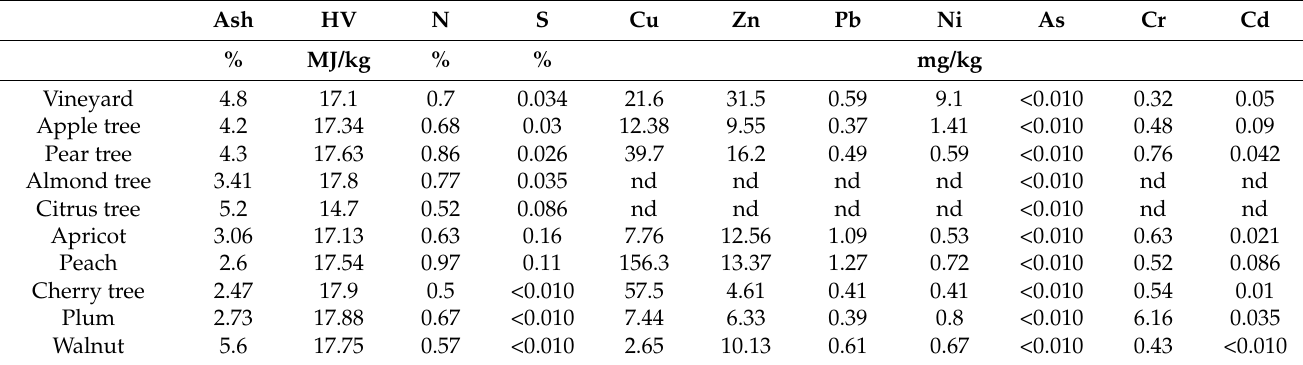
Table 9. Chemical and energy parameters of pruning of different fruit species.